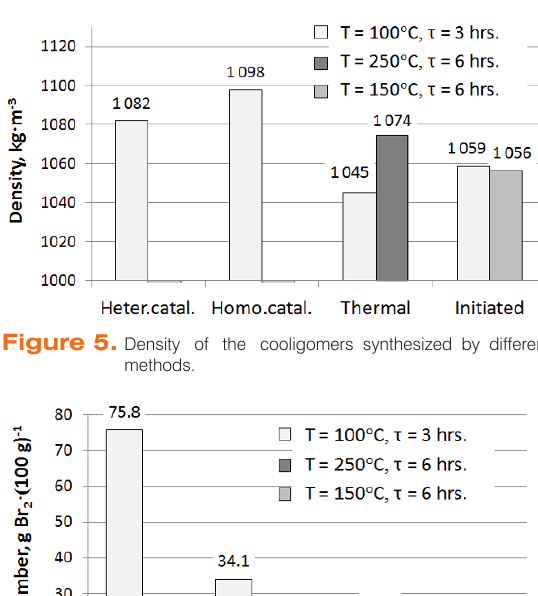
Figure 4. Polydispersity index of the cooligomers synthesized by different methods.